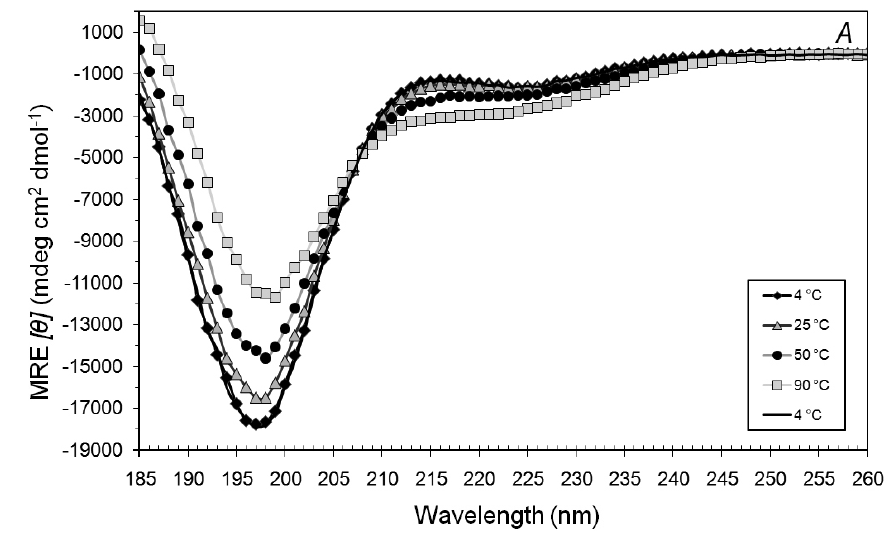
Figure 2. Mean residue ellipticity (MRE) of ( A ) 0.4 mM A ( C ) 0.2 mM A K and 0.2 mM A D, in water when heated stepwise from 4 °C to 90 °C and then 6 6 cooled back to 4 °C. Peptides appear to remain random-coiled and the spectra in (C) appears to be merely a combination of 2A and 2B, suggesting that structural changes due to the